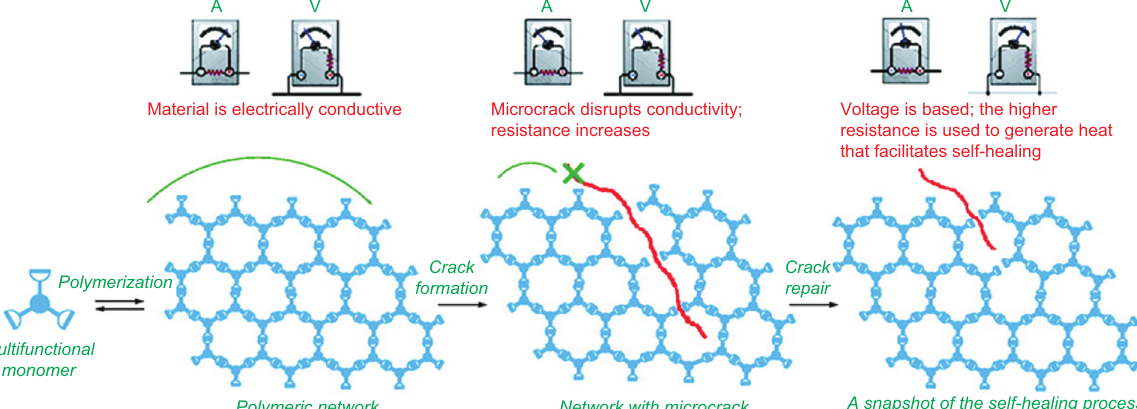
Figure 10 Image of the electrically triggered self-healing mechanism (reprinted with permission from [43]). Copyright 2007, The Royal Society Interface.